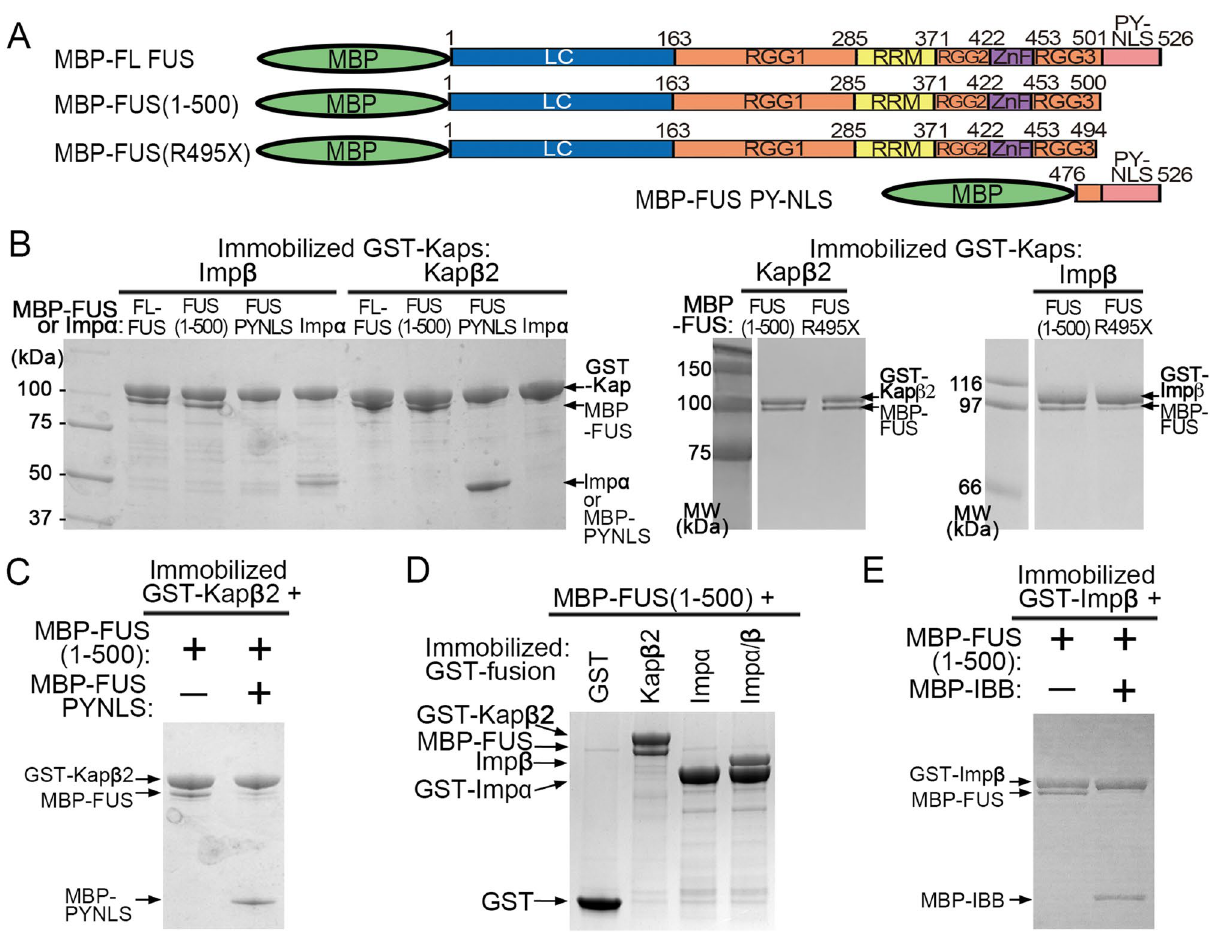
Figure 2. Interactions of FUS with Importins. ( A ) FUS constructs used in ( B – E ). ( B ) Pull-down binding assay showing interactions between MBP-FUS, MBP-FUS(1–500), MBP-FUS(R495X), MBP-FUS PY-NLS or Impα with GST-Impβ or GST-Kapβ2 immobilized on beads. Control experiments and unbound proteins in the pull- down experiments are shown in Supplementary Fig. 1A. ( C ) Pull-down binding assay of MBP-FUS(1–500) with immobilized GST-Kapβ2 in the presence of MBP-FUS PYNLS. ( D ) Pull-down binding assay to probe interactions between MBP-FUS(1–500) and GST-Kapβ2, -Impα or -Impα/β. ( E ) Pull-down binding assay of MBP-FUS(1–500) with immobilized GST-Impβ in the presence of MBP-IBB. Proteins in ( B–E ) are visualized by Coomassie-stained Impβ and Kapβ2 binds FUS(R495X) and inhibits its self‑association. FUS(R495X) is localized to both the cytoplasm and the nucleus, but it is unclear how a fraction of the protein is transported into the nucleus when it is missing the PY-NLS, which is the key element for nuclear import of full-length (FL) FUS 8,13 . It is known that Kapβ2 binds tightly to the PY-NLS, and weakly and dynamically to all other regions of FUS 12,18 . It is not known if and how FUS(R495X) binds to Kapβ2 or other importins. We performed pull-down binding assays using GST-Impβ, GST-Impα and GST-Kapβ2 that are immobilized on beads and MBP-fusion proteins of FL-FUS, FUS(R495X) (residues 1–494), the slightly longer FUS(1–500) and the FUS PY-NLS (residues 475–526) (Fig. 2A–E and Supplementary Fig. 1). As expected, Kapβ2 binds FL-FUS and FUS PY-NLS , but it also unexpectedly binds both FUS(R495X) and FUS(1–500) (Fig. 2B). Furthermore, although Impβ is not known to be a nuclear importer of FUS, it binds FL-FUS, FUS(R495X) and FUS(1–500) but not FUS PY-NLS (Fig. 2B). Isothermal titra- tion calorimetry (ITC) analysis shows that both FUS(R495X) (K D = 330 nM) and FUS(1–500) (K D = 161 nM) bind similarly to Kapβ2, but weaker than the FUS PY-NLS (K D = 31 nM) (Table 1, Supplementary Figs. S2 and S3). Kapβ2 binds FL FUS tightly through its PY-NLS, but can still bind the truncated protein with moderate affinity when the PY-NLS is not present. FUS(1–500) is only six amino acids longer than FUS(R495X) and clearly binds Kapβ2 and Impβ similarly. Many experiments below use FUS(1–500) as a proxy for FUS(R495X). Figure 2C shows that Kapβ2 does not bind FUS(1–500) in the presence of FUS PY-NLS, suggesting that the binding site for FUS(1–500) on Kapβ2 likely overlaps with that for the PY-NLS. Analogously, although FUS(1–500) binds Impβ (Fig. 2B), it no longer does so in the presence of Impα and FUS(1–500) does not bind Impα (Fig. 2D). Therefore, it appears that FUS(1–500) binds directly to Impβ but cannot bind the Impα/β heter- odimer. The Impβ-binding (IBB) fragment of Impα also inhibits Impβ interaction with FUS(1–500), suggesting that the binding site for FUS(1–500) on Impβ likely overlaps with that for the IBB (Fig. 2E).